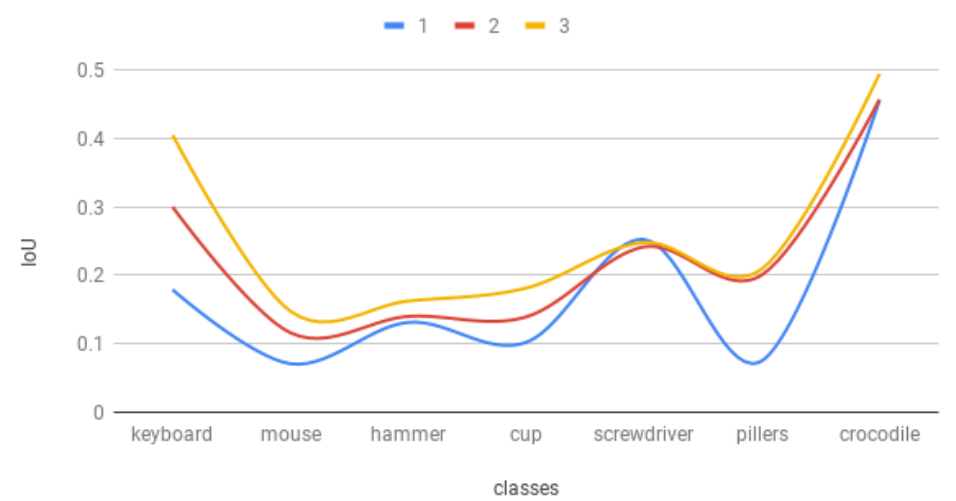
Figure 14. Comparison of the results of the research after training sessions on three prepared datasets (1-original, 2-first modification, 3-second modification).